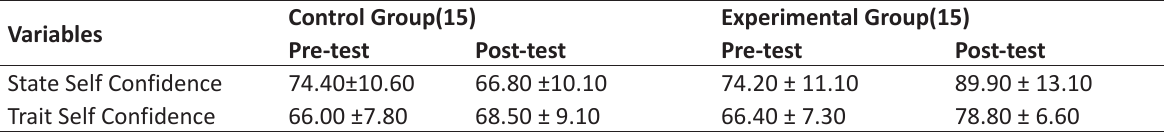
Table 3 . Levene’s test for variances homogeneity Dependent variables